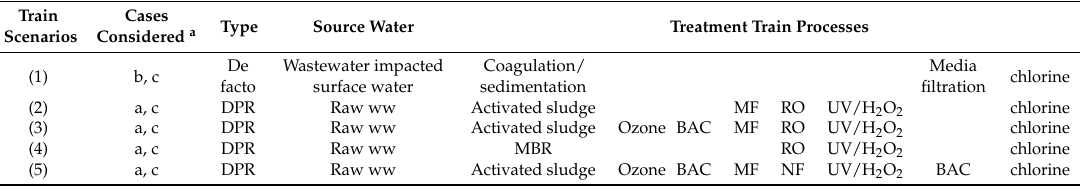
Table 1. Treatment train scenarios examined for de facto reuse and direct potable reuse (DPR). Wastewater is shortened to ww. The log removal values used for activated sludge and membrane bioreactor (MBR) processes include primary sedimentation.